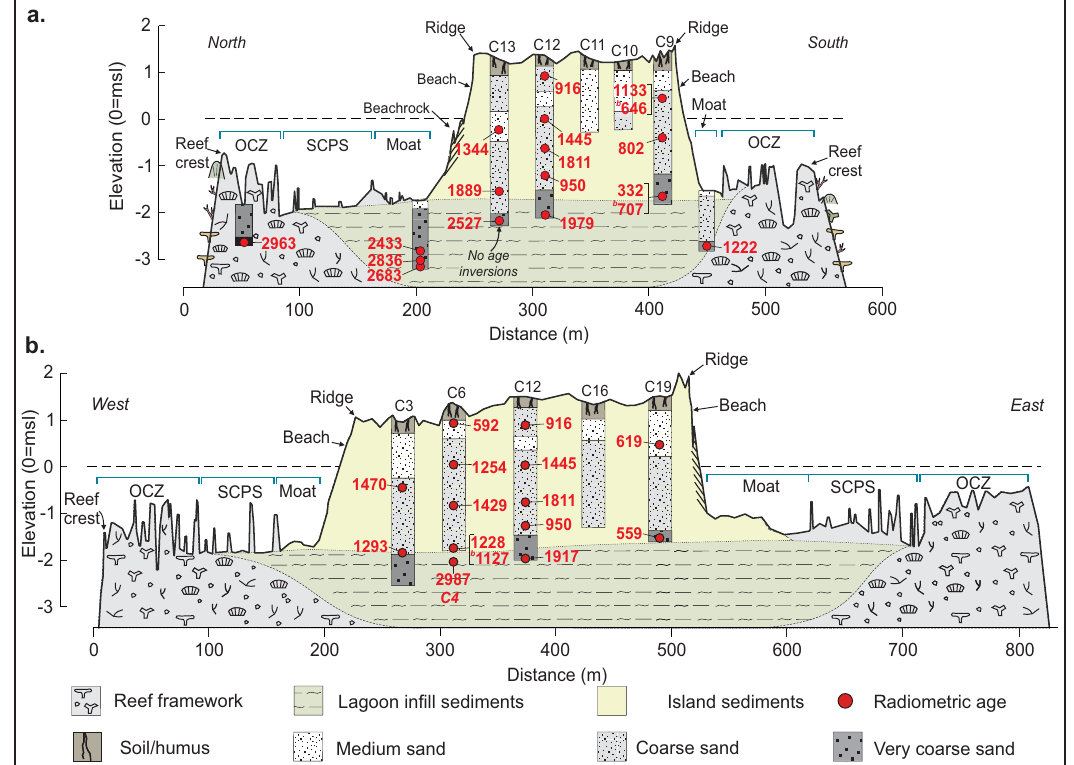
Fig. 2 | Summary ofKandahalagalaareef platform and island topography, and chronostratigraphy. a North – South topographic survey along transect T3 with summary core hole stratigraphy and radiometric ages. b West – East topographic surveyshowingsummarycoreholestratigraphyandradiometricages.Thelocation